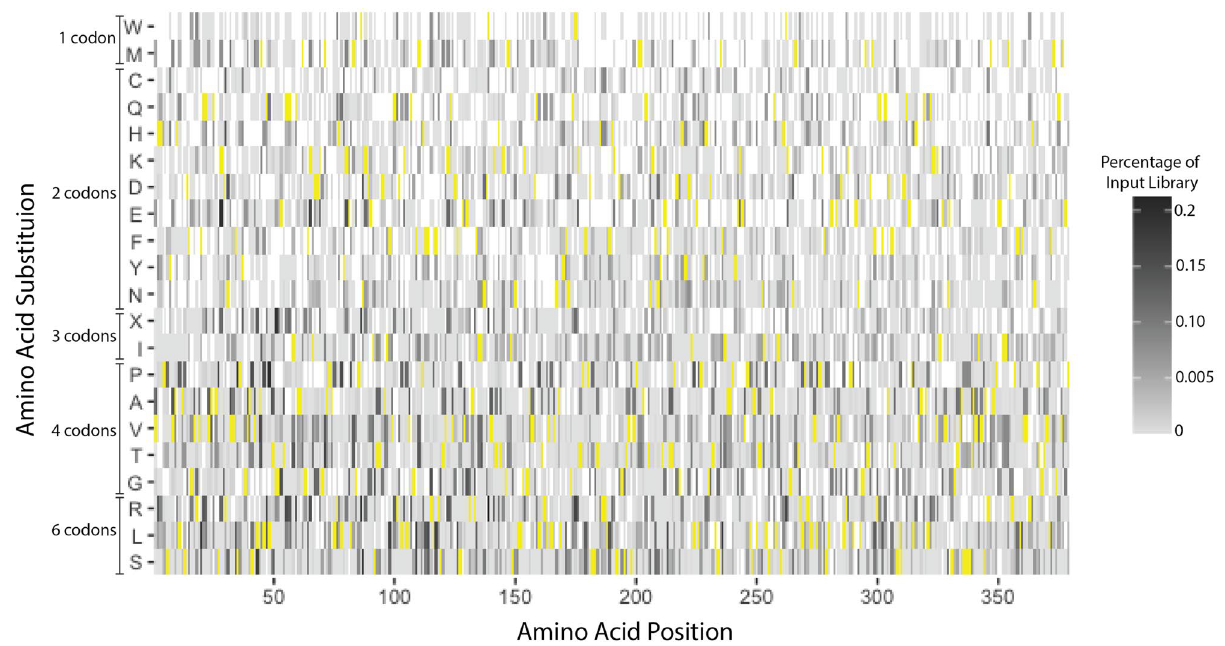
Figure 3. phPAI-1 mutant library generated by error prone PCR includes more than two-thirds of all possible missense mutations. The mutational library contains 71% of all possible missense and nonsense mutations with 27% of all missense variants present with sufficient depth (base mean score > 10, p adj < 0.05) to accurately determine the effects of the mutation on PAI-1 function. The primary amino acid position within PAI-1 is indicated along the x-axis and single amino acid substitutions are listed along the y-axis. WT amino acid residues are indicated in yellow, while missense and nonsense (X) mutations not present in the input library are shown in white. Variants present within the library are shown in grey (see scale) as a percentage of the input library represented by that variant. This figure was generated using Adobe Illustrator 2021 version 25.2.3 and the ggplot2 package version 3.3.3 for RStudio version